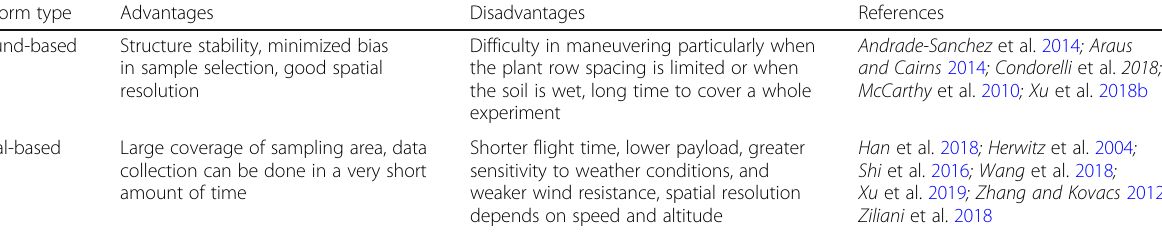
Table 2 Advantages and disadvantages of ground-based and aerial-based types of platforms for cotton phenotyping Platform